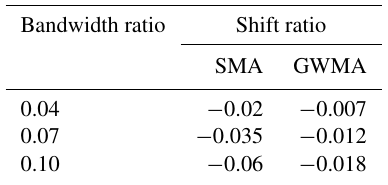
Table 3. Shift ratios used for lag minimization of Geocube 46 dis-